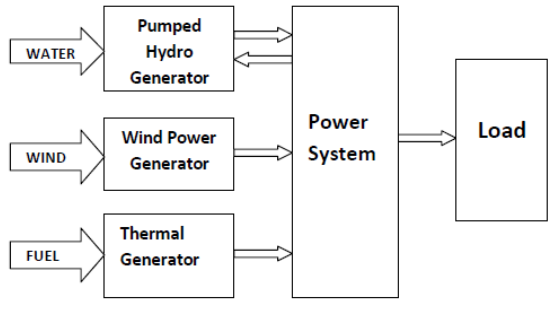
Figure 7. Operational block diagram of the